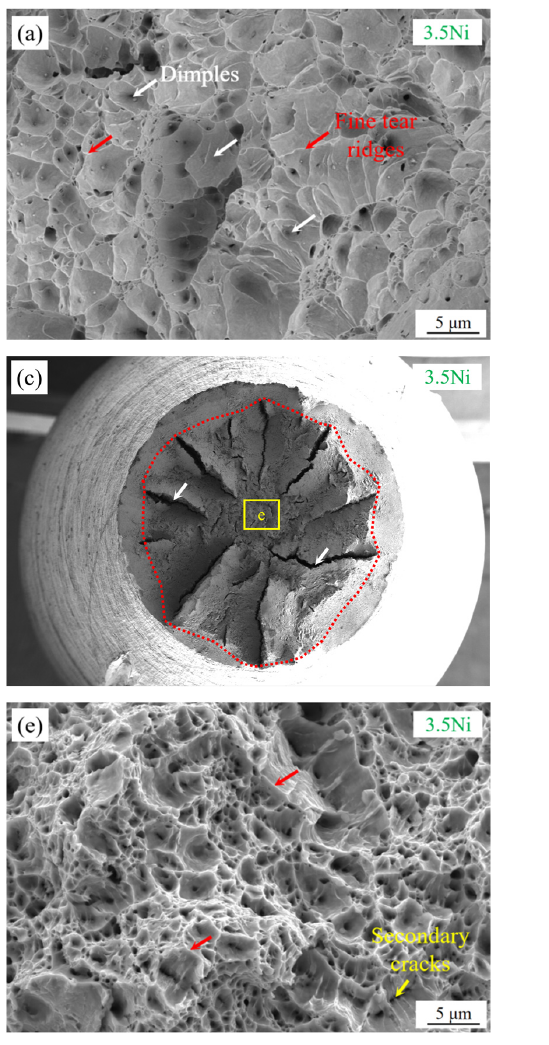
Figure 15. ( a , b ) Tensile fracture micrographs for the quenched samples. ( c – f ) Representative tensile fracture morphology of the two steels after tempering, taking samples T500 as an example; ( c , d ) The low magnification fracture morphologies of samples T500 of two steels; ( e , f ) showing high magnification image of region e and f in image ( c , d ).